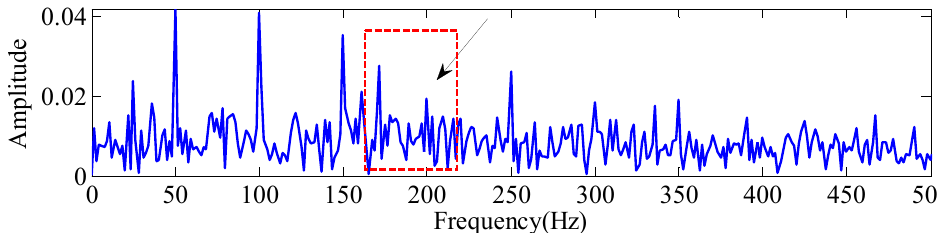
Figure 13. Manual selection of the signal segment at 2 s to construct the envelope spectrum of the noise reduction signal of the Hankel matrix.